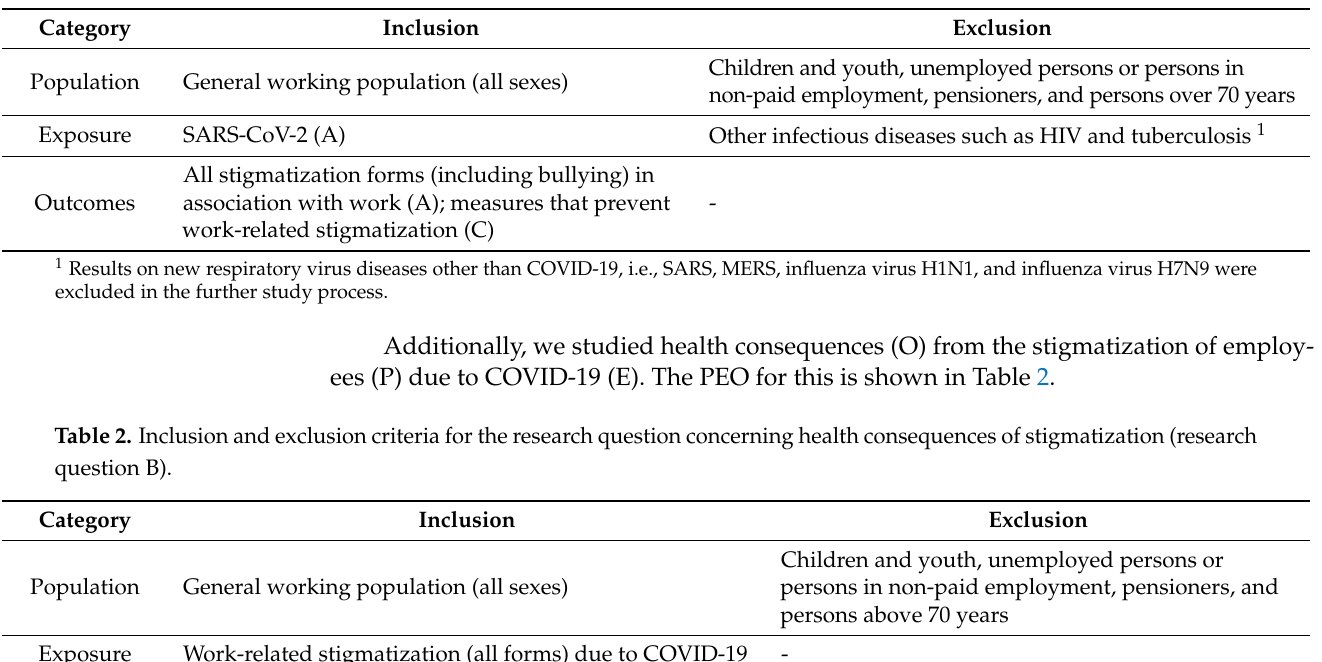
Table 1. Inclusion and exclusion criteria for the research question concerning work-related stigmatization as outcome (research question A and C).